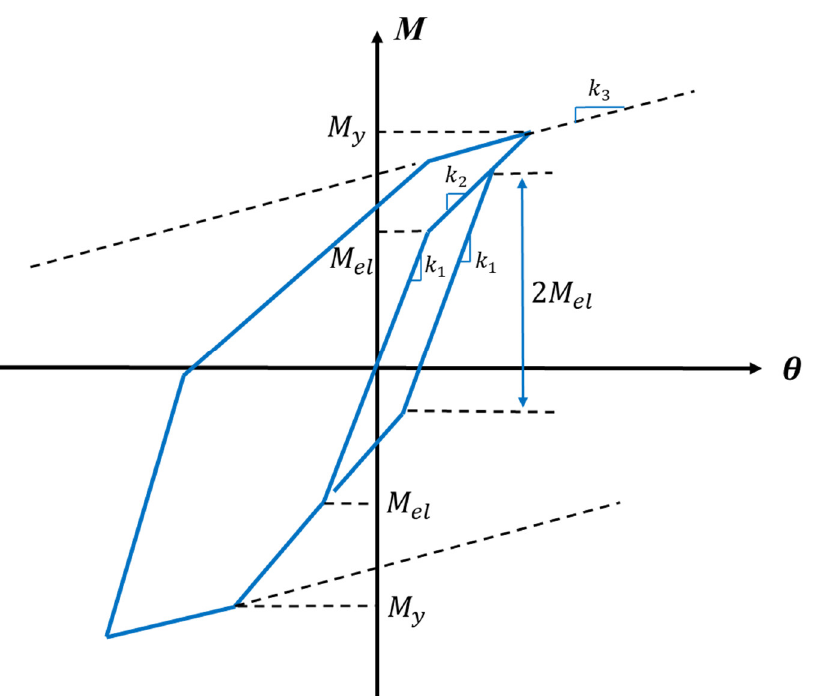
Figure 12. Simplified behavior of the semi-rigid connection behavior by Stelmack et al. [46]. Using the proposed configurations, the analytical moment–rotation model reproduced the experimental model accurately, as shown in Figures 13–15. The quasi-static loading consisted of three cycles and in each cycle the numerical and experimental models agreed well with each other. In general, the numerical and experimental models agreed well with each other and the degradation backbone was captured very well.